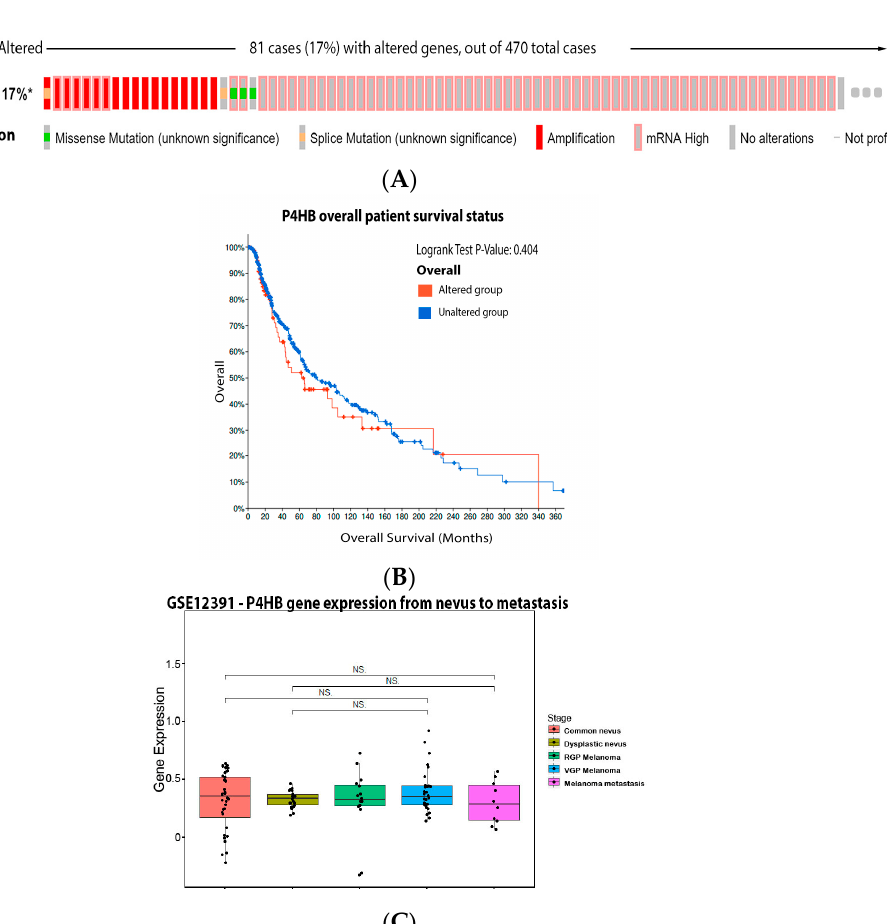
Figure 8. Protein disulfide isomerase on melanoma. ( A ) Percentage of patients with altered genes and types of genetic alterations; ( B ) overall patient survival status, and ( C ) expression in melanoma progression. Red boxes represent the common nevus, yellow boxes the dysplastic nevus, green boxes the radial growth phase (RGP) melanoma, blue boxes the vertical growth phase (VGP) melanoma, and purple boxes the metastatic melanoma. The statistical analysis was performed by ANOVA followed by Tukey test, * p < 0.05 when compared to common or dysplastic nevus. NS: Not